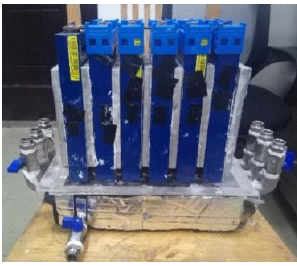
Figure 4. The construction of coolant circulation cooling system (CCCS).